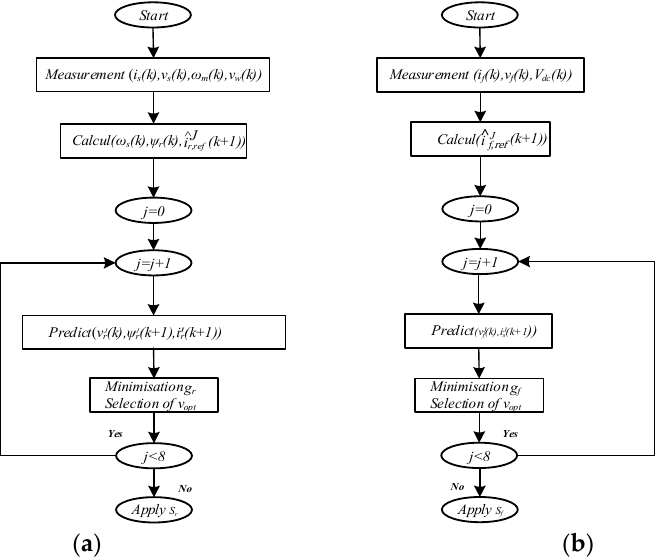
Figure 5. Flowchart of the algorithm MPCC for RSC ( a ) and GSC ( b ).